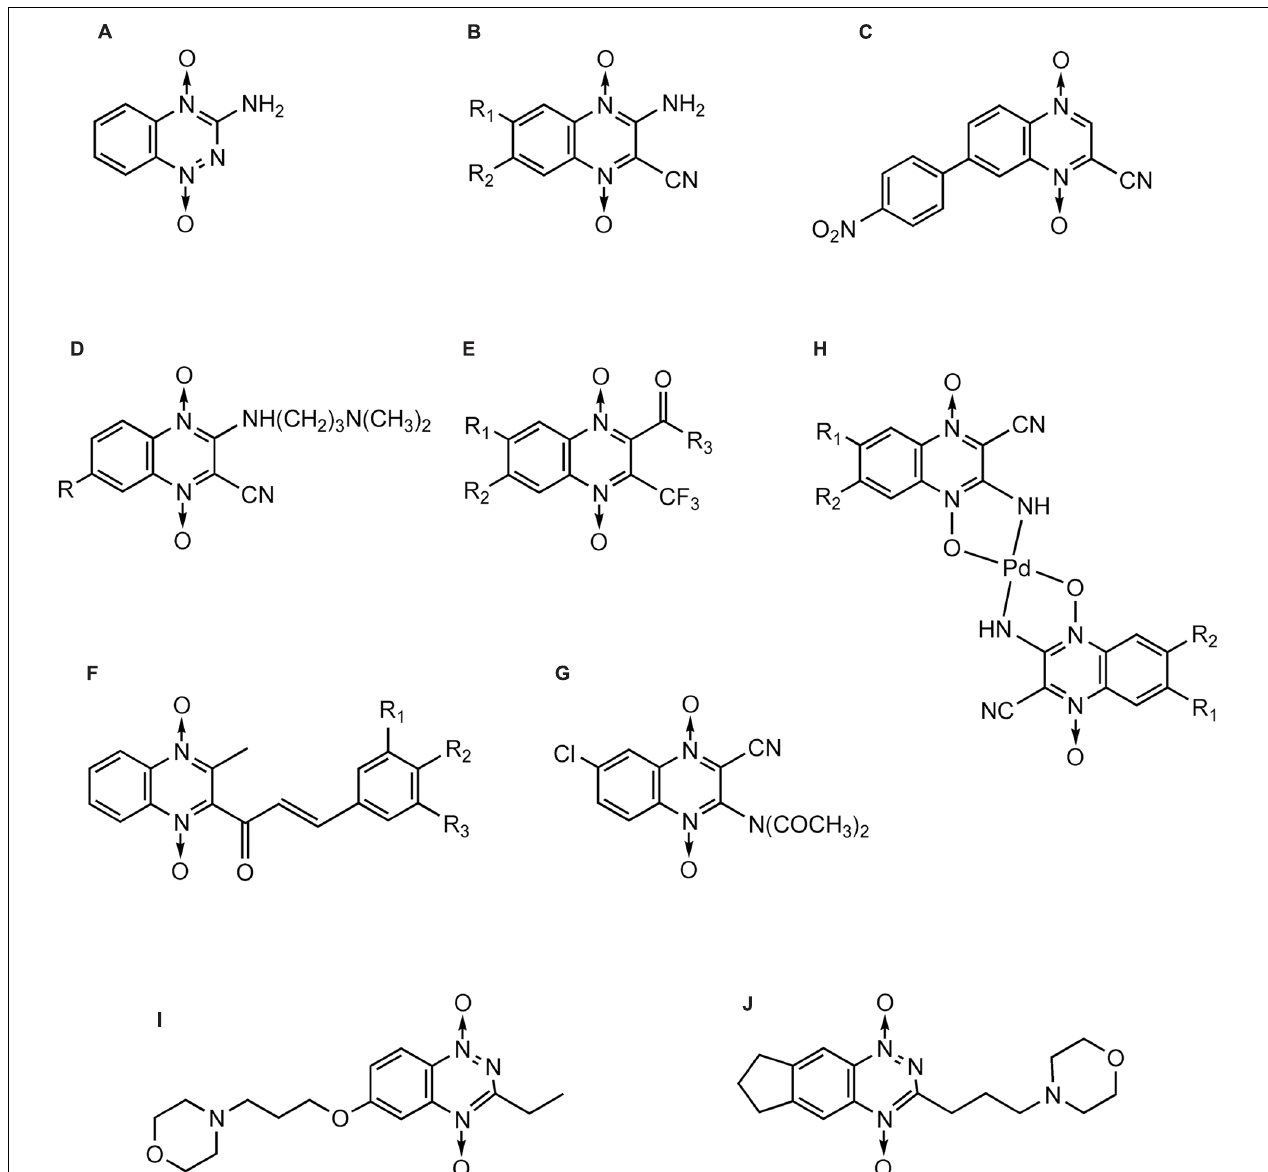
FIGURE 6 | QdNOs with hypoxia-selective and antitumoral